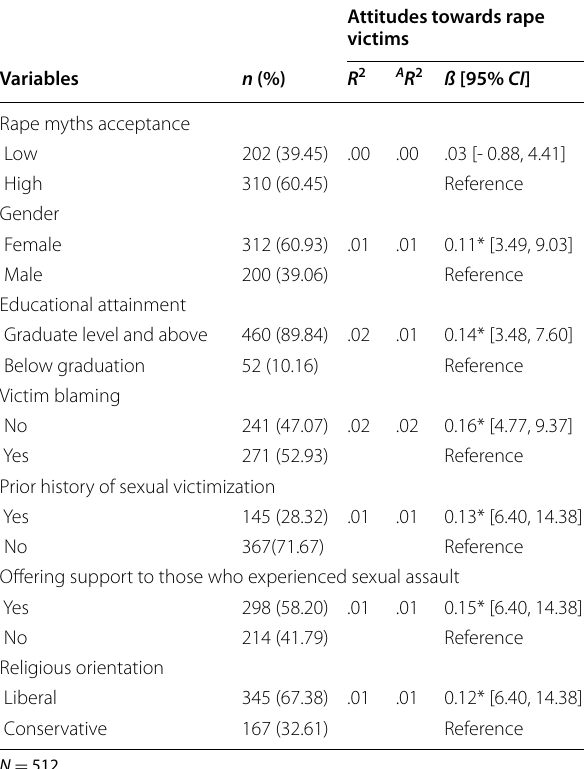
Table 3 Regression of associations among rape myths acceptance, gender, educational attainment, victim blaming, prior history of sexual victimization, and support for friends experiencing sexual assault on attitudes towards rape victims